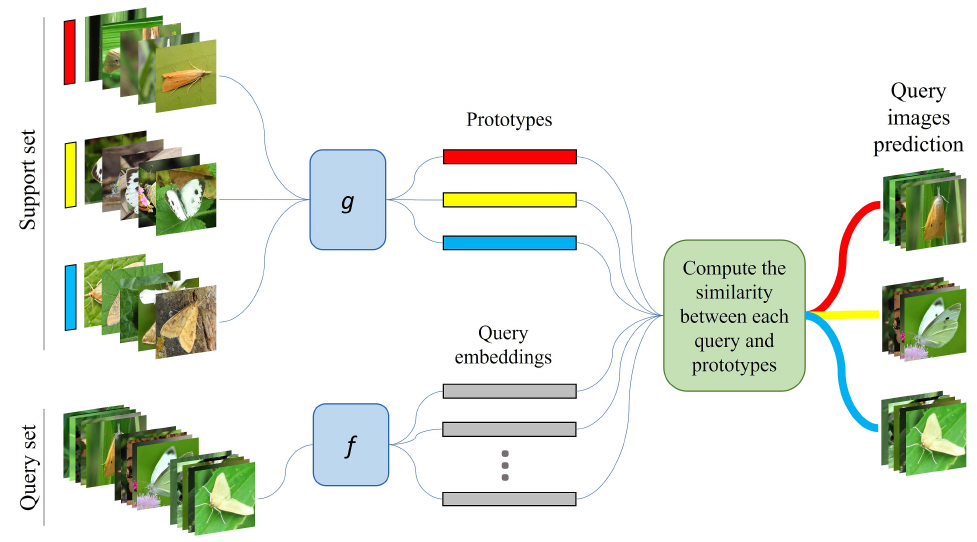
Figure 6. Instance of Adult stage insect classification in 3-way, 5-shot and q = 5.